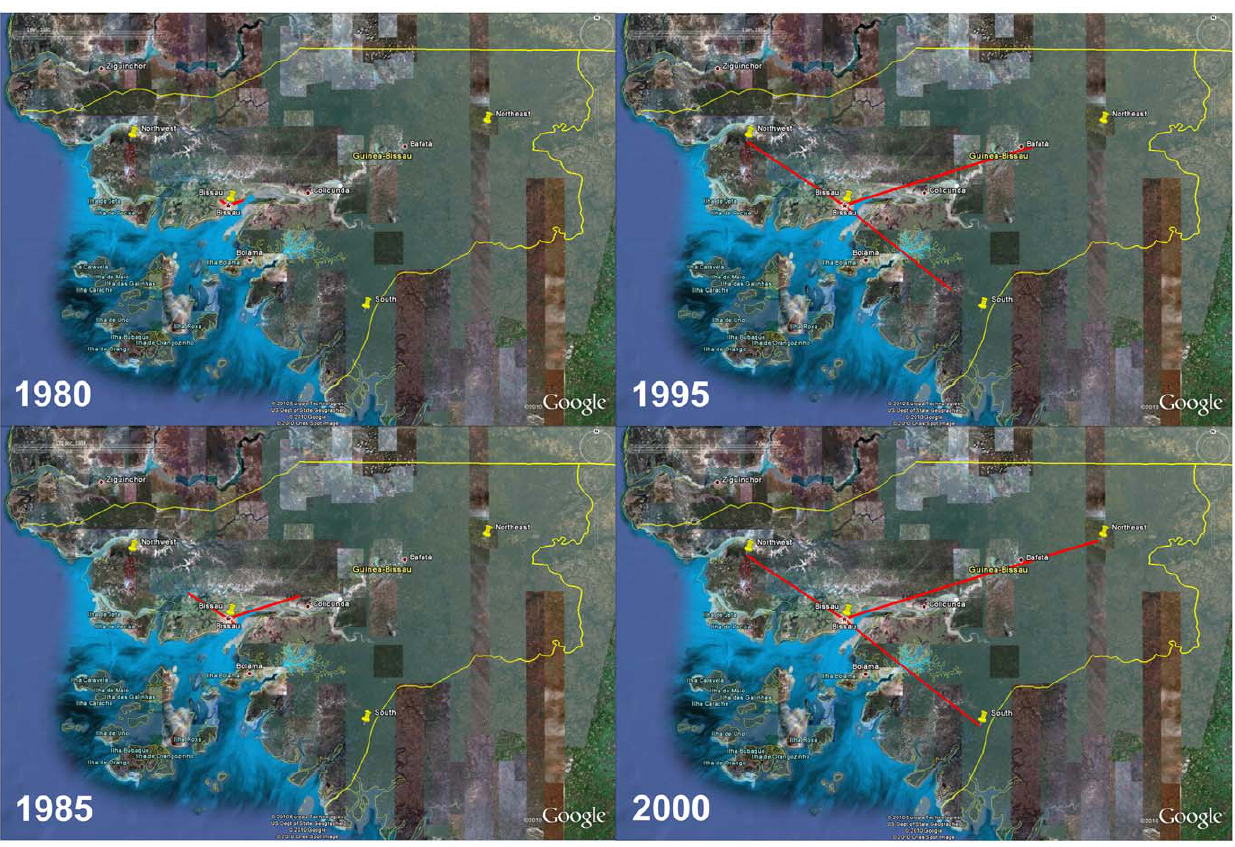
Figure 4. Temporal dynamics of spatial HIV-1 CRF02_AG diffusion within Guinea-Bissau. Snapshots of the HIV-1 CRF02_AG dispersal pattern within Guinea-Bissau. Lines between locations represent branches in the maximum clade credibility tree (MCC) along which well-supported location transitions occurs. The diffusion process was visualized in Google Earth (http://earth.google.com).